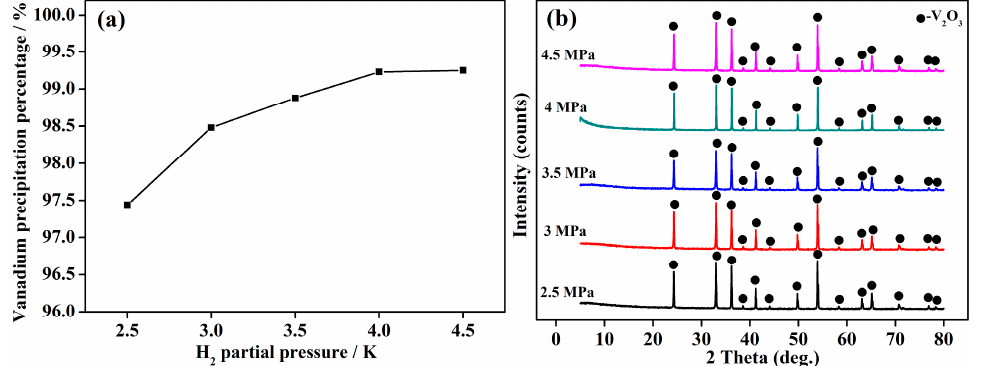
Figure 8. ( a ) Effect of H 2 partial pressure on the vanadium precipitation percentage; ( b ) XRD patterns of the precipitates obtained at different H 2 partial pressure.